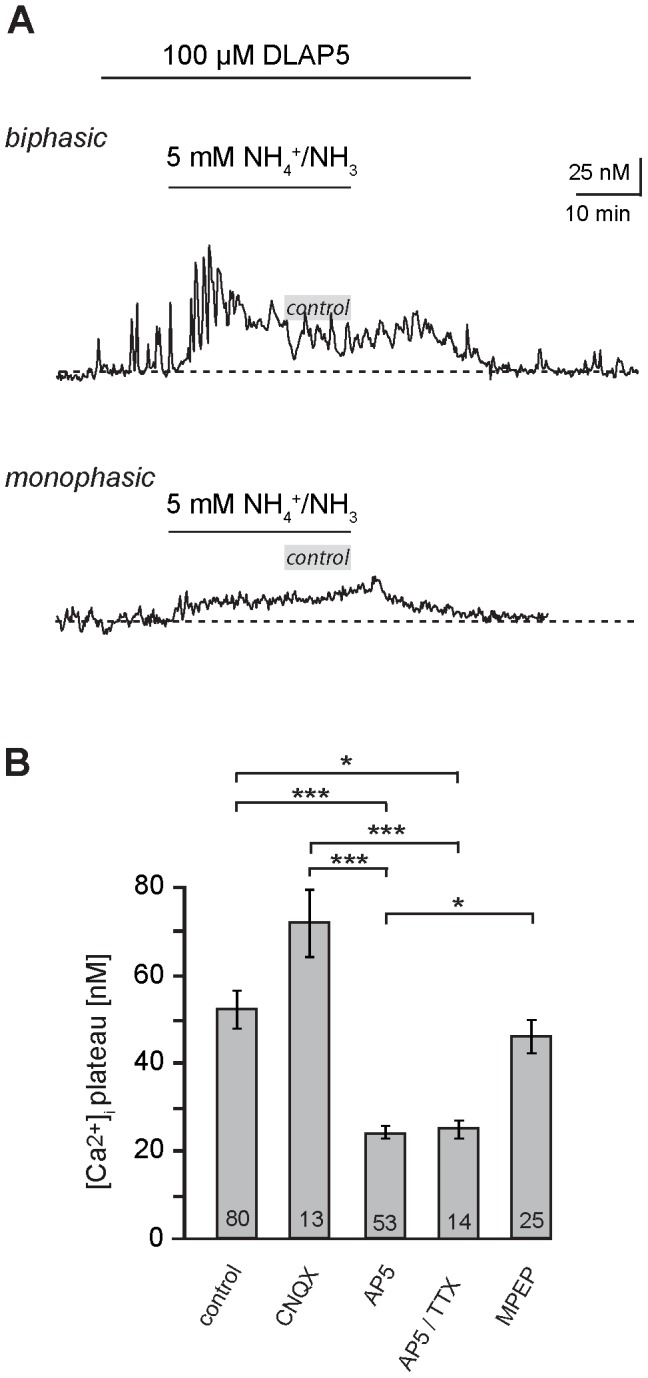
Involvement of glutamate receptors in NH4
+/NH3-induced calcium changes.
(A) Influence of the NMDA-receptor blocker DL-AP5 (100 µM, indicated by bar) on NH4
+/NH3-induced calcium changes in a biphasic (upper trace) and a monophasic (lower trace) hippocampal astrocyte. The grey bars indicate the average amplitude of the sustained calcium increase evoked under control conditions in the absence of DLAP5 (∼50 nM). (B) Histogram showing the mean peak amplitude ± S. E. M. of sustained calcium changes in response to NH4
+/NH3 in the control, and in the presence of the glutamate receptors blocker CNQX, DLAP5 (AP5), DLAP5 in the presence of TTX, or MPEP. The number of cells is given within the bars. AP5 and AP5/TTX reduce the amplitude of calcium increases significantly as compared to the control (***: p<0.001; *: p<0.05).